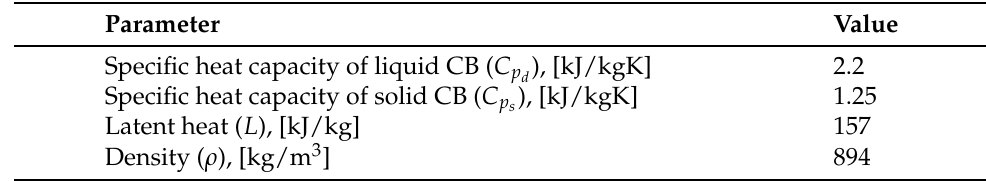
Table 1. Thermophysical properties of CB that have been used in the solidification model equations.